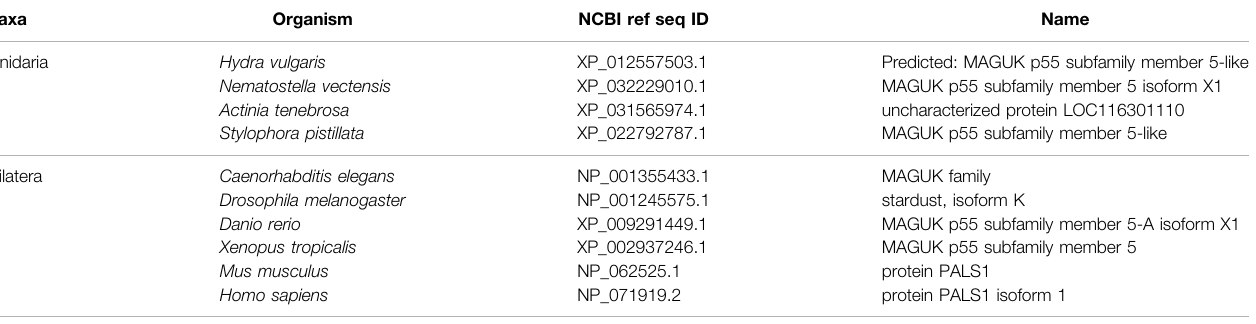
TABLE 6 | Stardust/PALS1/MPP5.